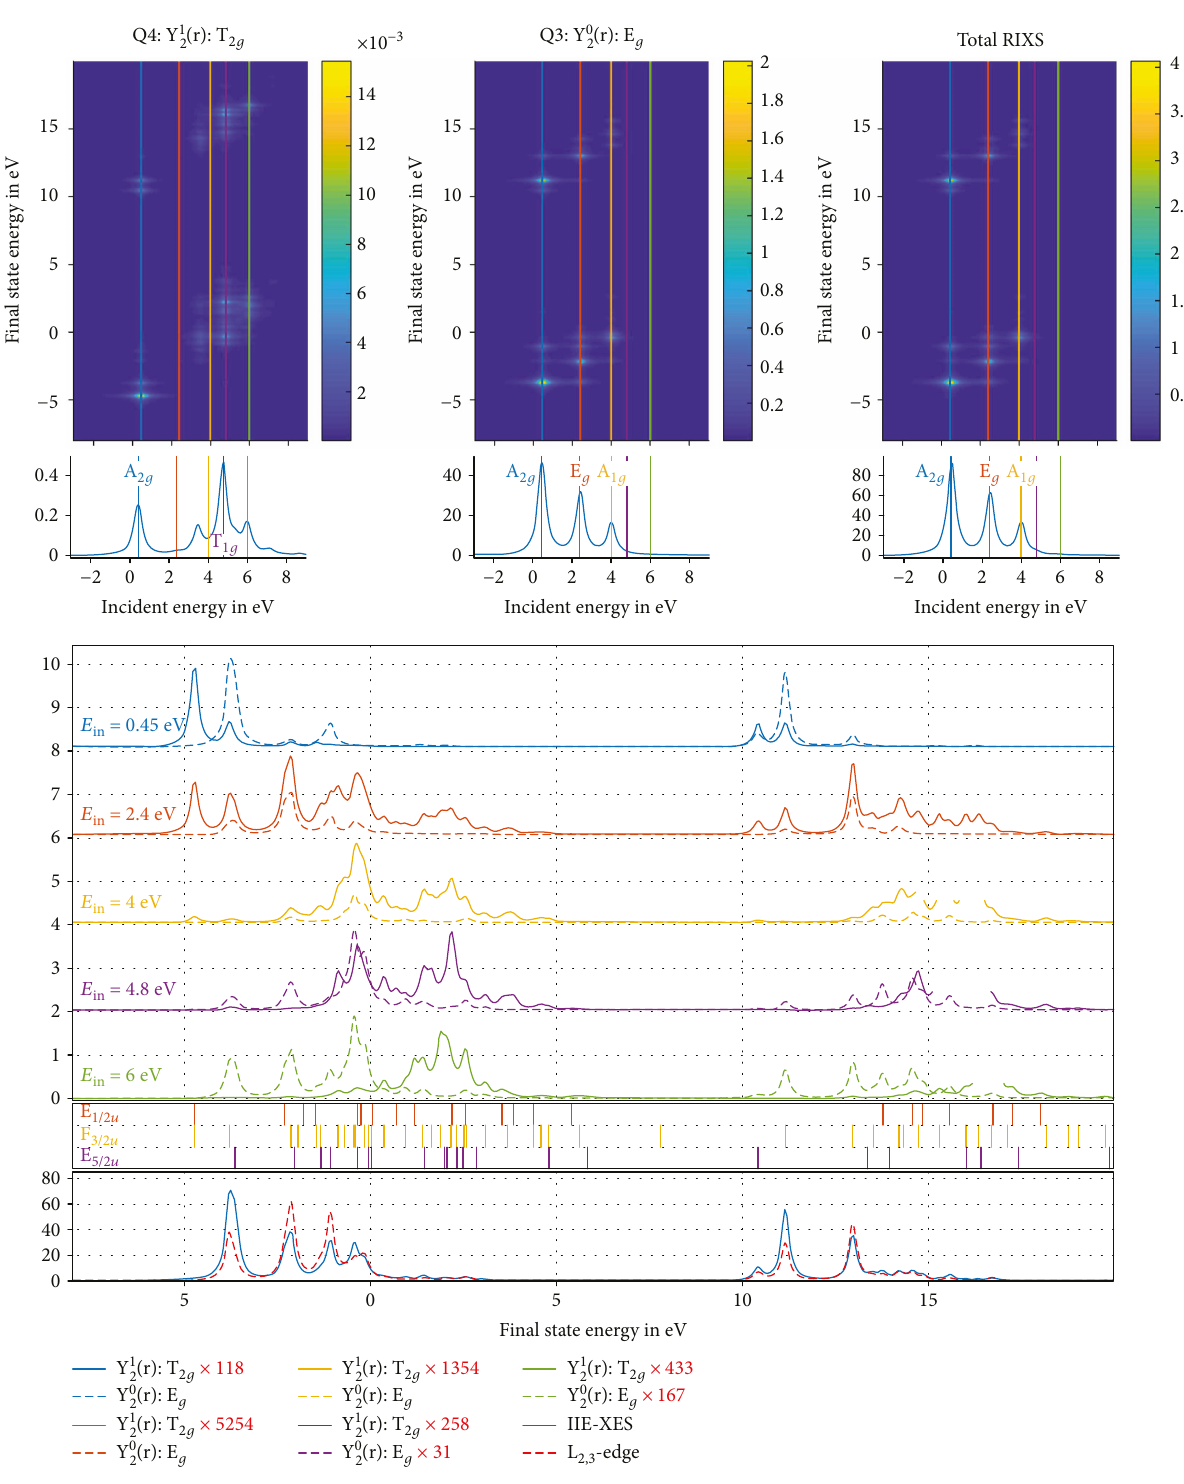
Figure 56: Calculated 1s2p RIXS spectrum for Co 2+ ( 3d 7 ) for 10D q = 3 0 eV (low